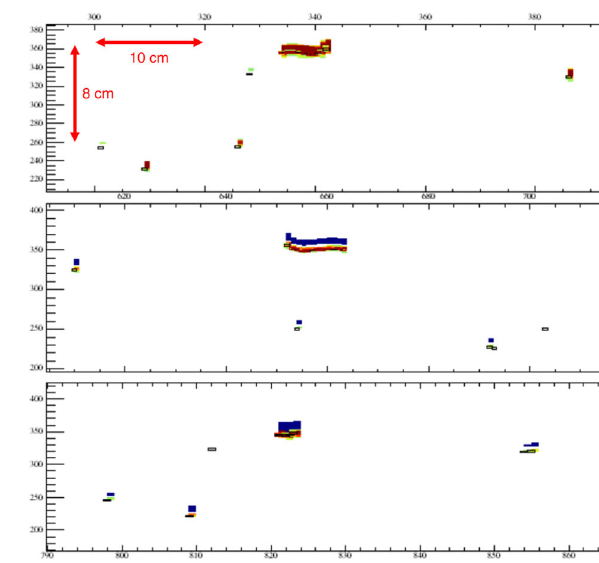
represent reconstructed hits. Right: simulated ν e CC event (20.25 MeV neutrino), showing electron track and blips from Compton-scattered gammas. The events have different spatial scales, as indicated on the